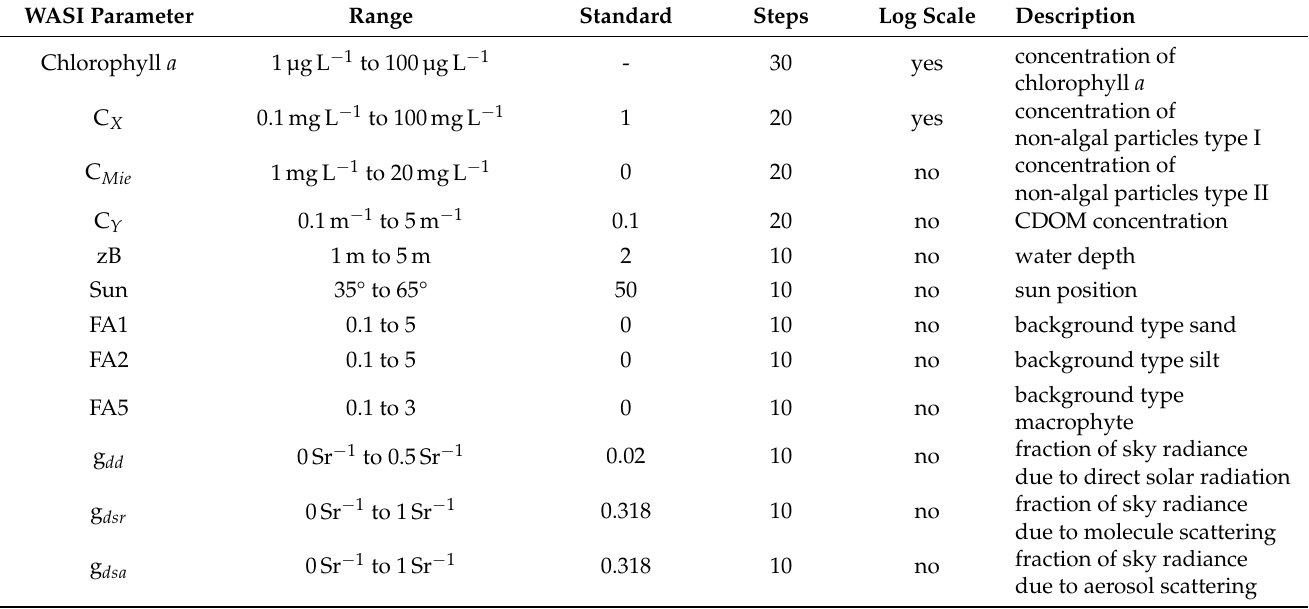
Table 2. Summary of the relevant Water Color Simulator (WASI) simulation parameters with their respective range. The sampling schema is described in Figure 3. The range and the respective steps define the possible occurring parameter values. For chlorophyll a and the concentration of non-algal particles, a logarithmic scale is chosen. WASI Parameter Range Standard Steps Log Scale Description Chlorophyll a 1µgL − 1 to 100µgL − 1 -